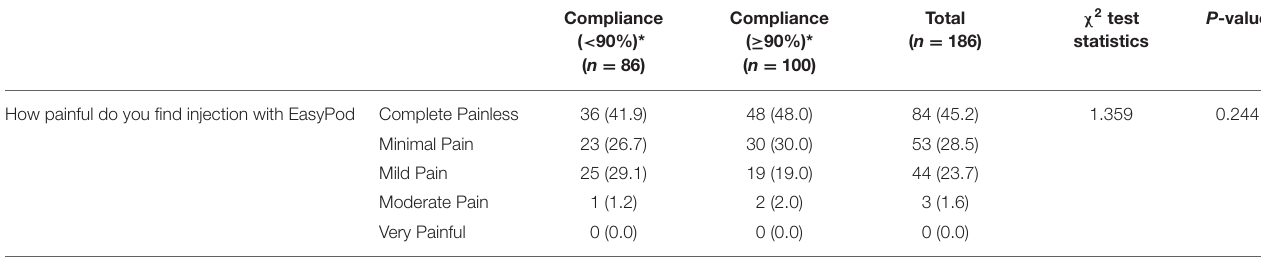
TABLE 4 | Comparison between compliance groups for the perception of pain with EasyPod TM device ( N = 186).